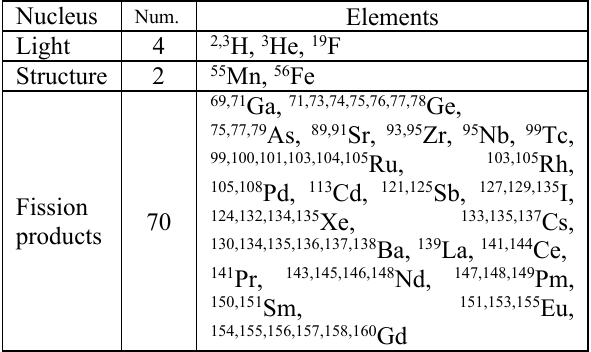
Fig. 3. The comparison of the obtained 209 Bi(n,2n) cross sections and uncertainty and the relevant measurements. Table 2. The nucleus of covariance evaluation in CENDL-3.2.